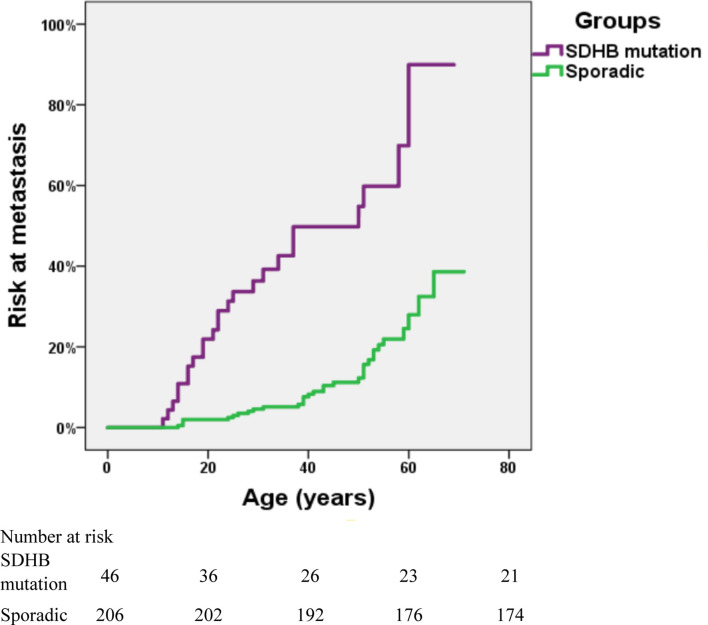
Risk of metastasis in SDHB-mutated and sporadic PPGL patients. Kaplan-Meier analysis includes 46 SDHB (succinate dehydrogenase subunit B) mutated PPGLs and 206 apparently sporadic PPGLs.